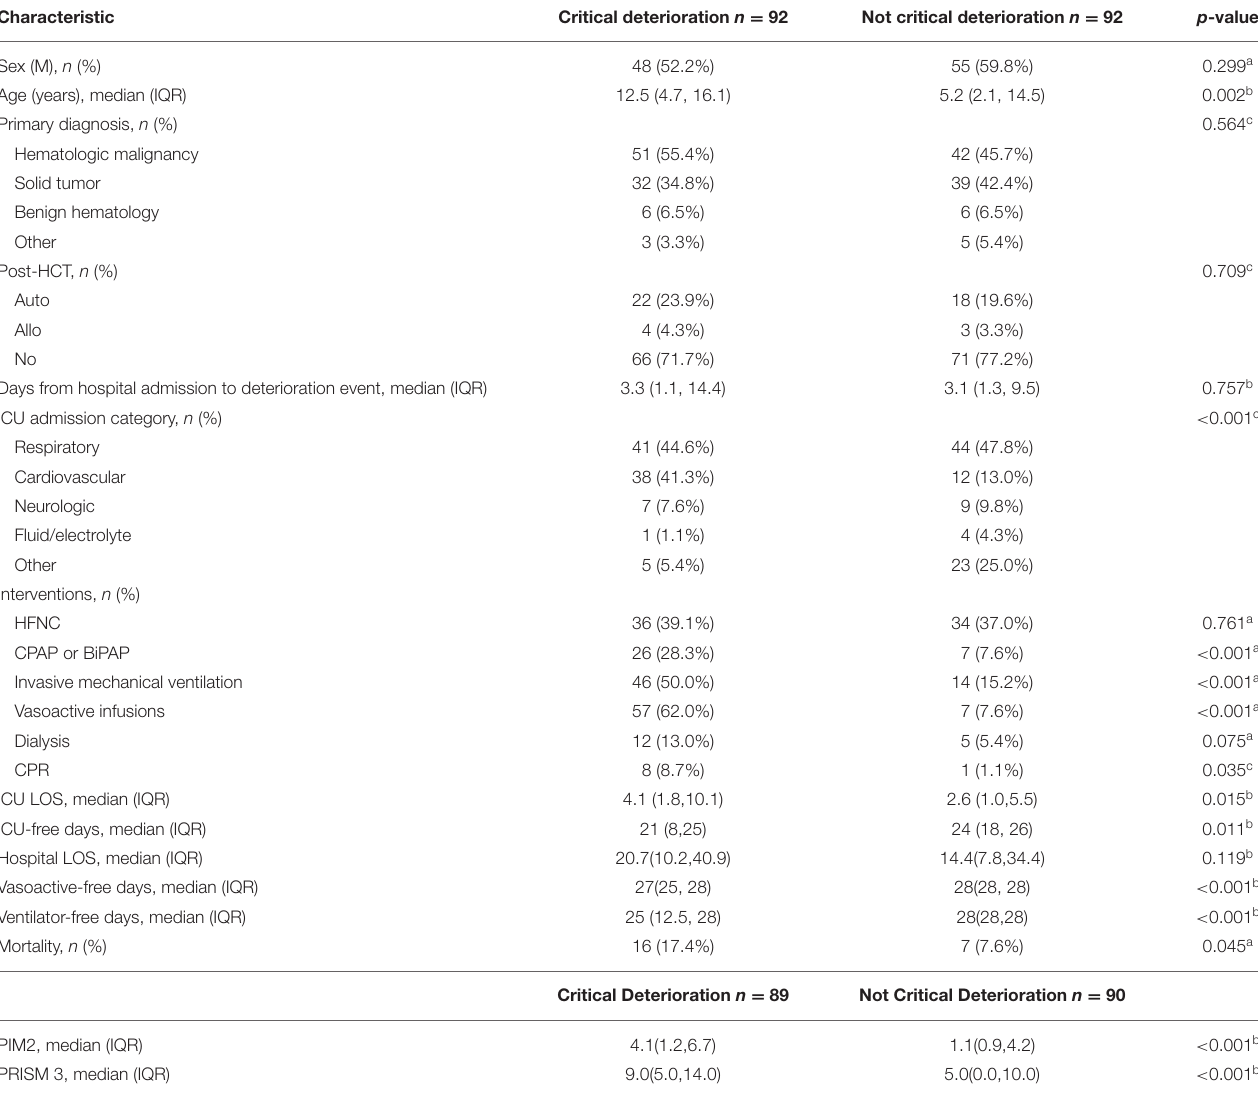
TABLE 2 | Critical deterioration in hospitalized pediatric hematology-oncology patients. Characteristic Critical deterioration n =